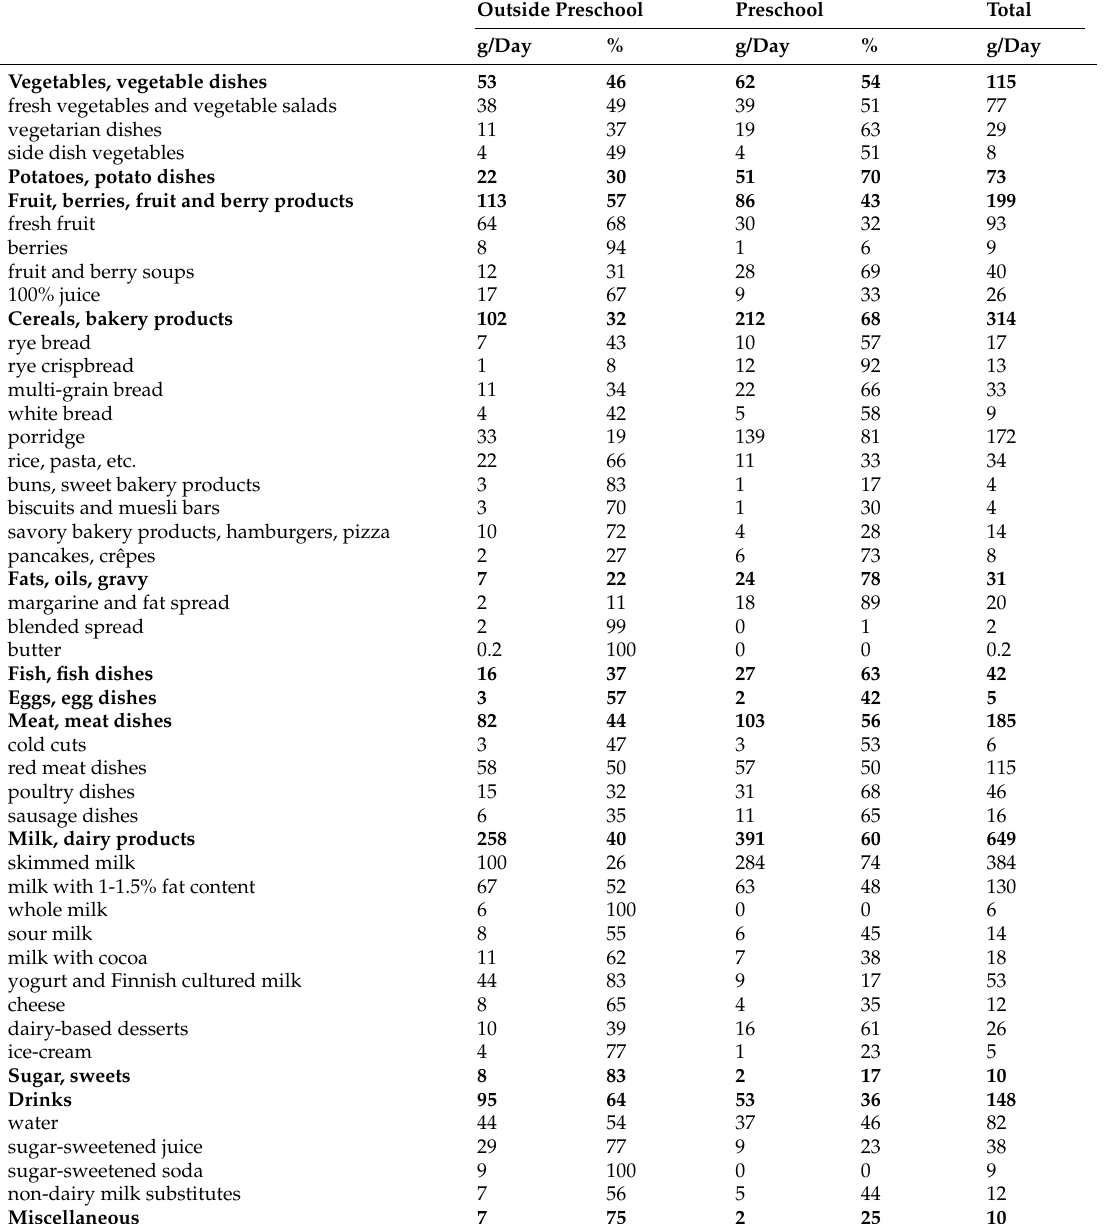
Table 3. Mean food consumption on preschool days (Monday to Friday) of 5- to 6-year-old Finnish children who eat three meals at preschool ( n =